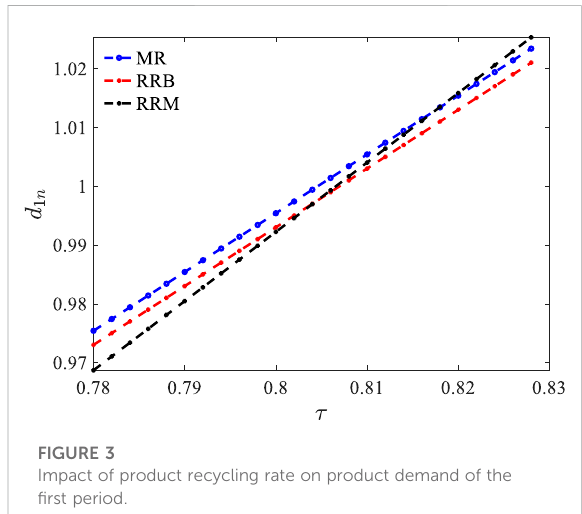
FIGURE 3 Impact of product recycling rate on product demand of the fi rst period.